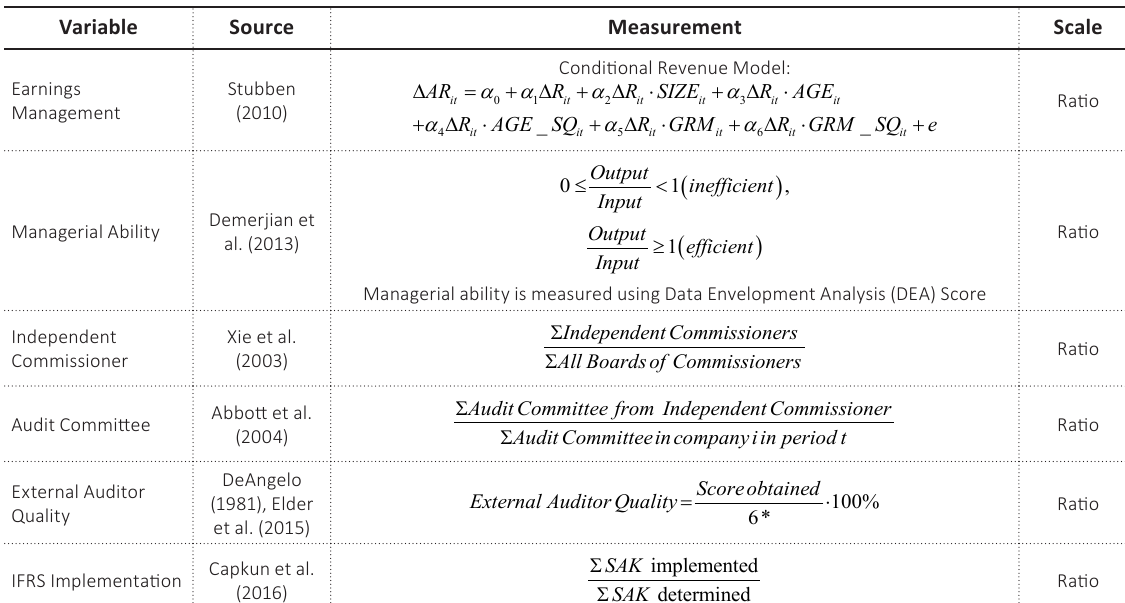
Table 1. Variables’